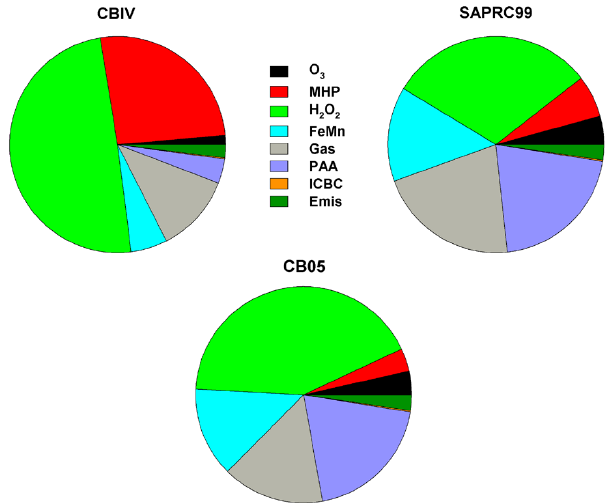
Fig. 4. Pie chart showing the percent contribution of sulfate forma- tion pathways to total sulfate for CBIV, SAPRC99, and CB05 on 20 July 2004 at